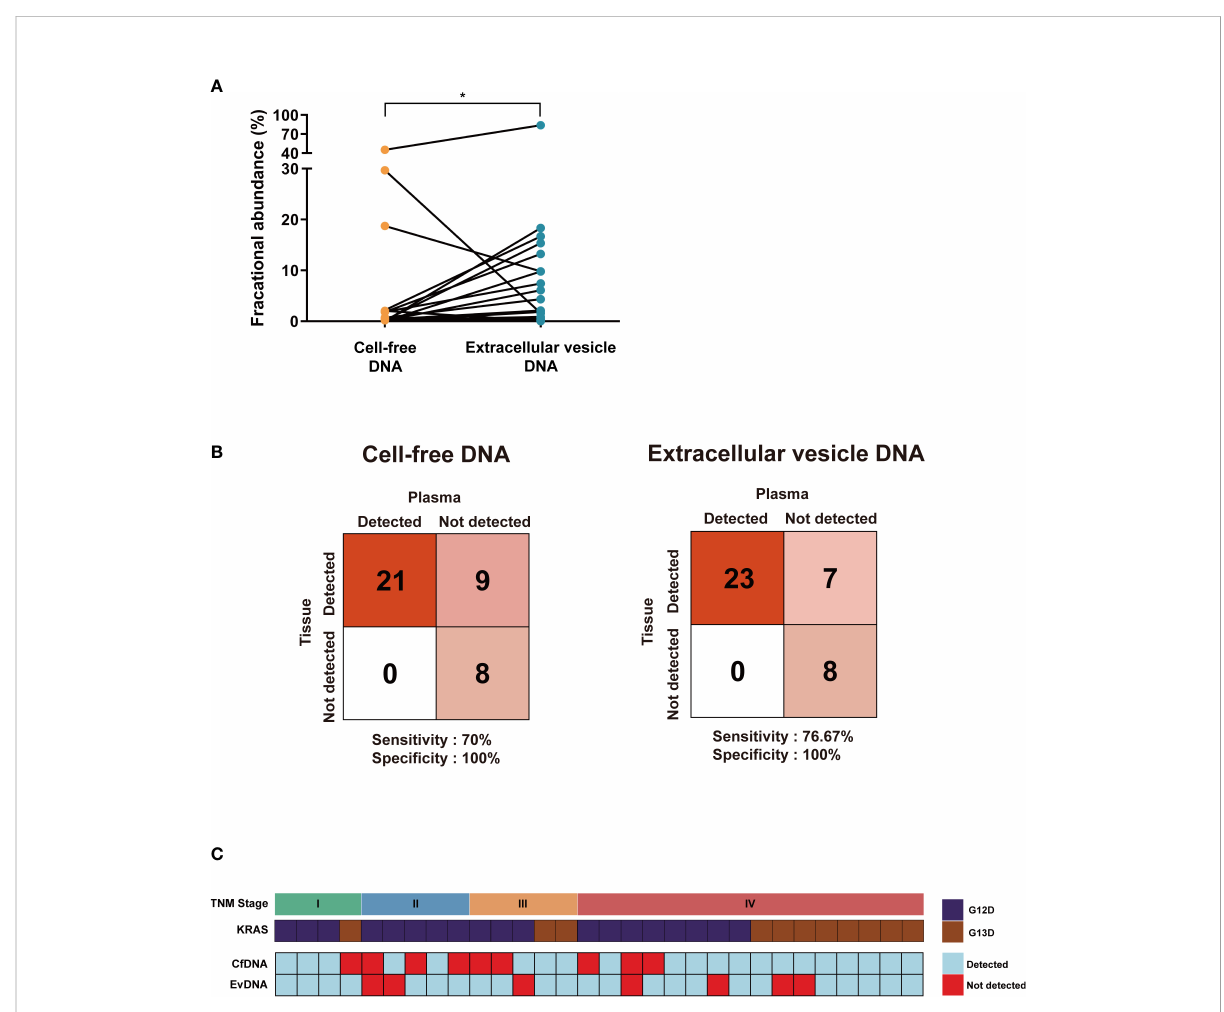
FIGURE 2 Comparing the mutation detection rates of cell-free DNA and extracellular vesicle DNA. (A) The mean of extracellular vesicle DNA fractional abundance was relatively higher than cell-free DNA. * P < 0.05. (B) A confusion matrix for detecting KRAS mutation of cell-free DNA (left) and extracellular vesicle DNA (right) compared with KRAS wild-type patient samples. The number of samples identi fi ed is noted in each box. (C) A detection table of cell-free DNA and extracellular vesicle DNA aligned with TNM stage and KRAS mutation status. Samples with fractional abundance greater than 0.1% are considered